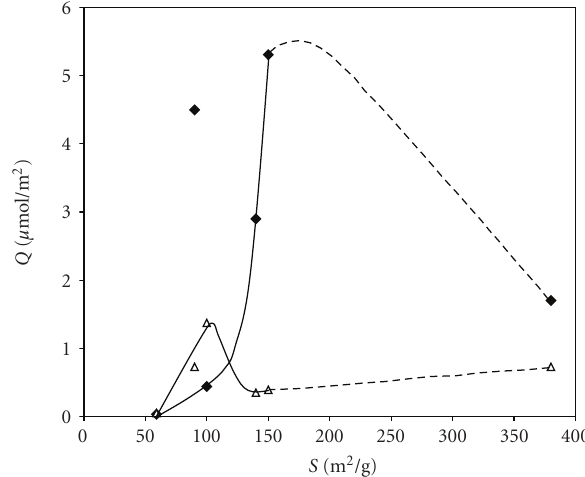
Figure 3: Content of adsorption centers with p K a –0.3 ( ), 6.4 ( ), and 14.2 ( ) on the surface of the studied samples as a function of their specific surface area. Note: the content of adsorption centers with p K a 14.2 is reduced 10-fold for the presentation convenience.